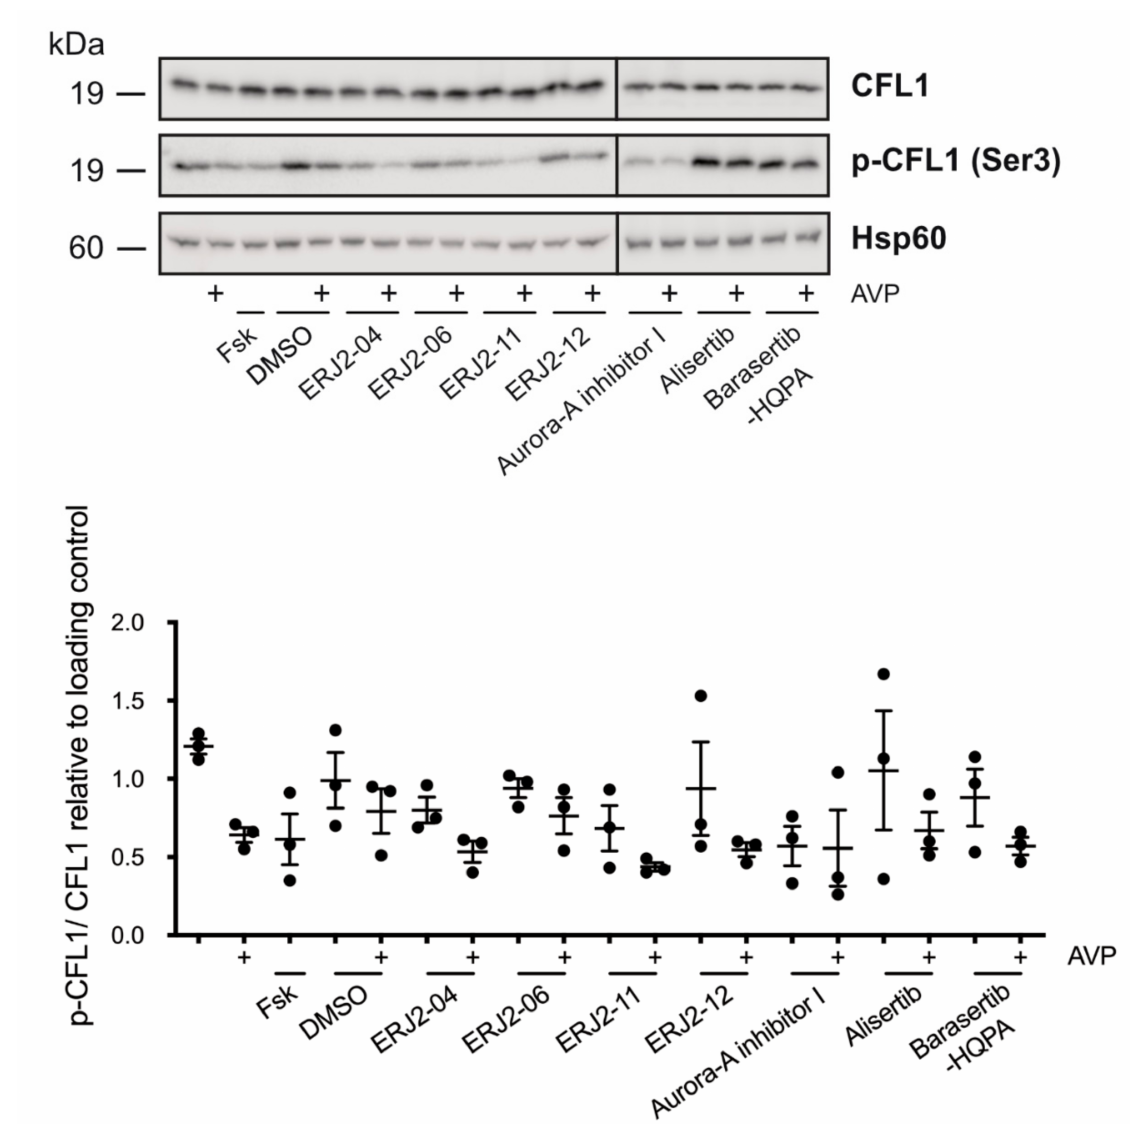
Figure 11. AURKA inhibitors affect the phosphorylation of CFL1 in primary IMCD cells. Cells were left untreated or treated with DMSO (0.2%, 1 h) or compound (20 µ M, 1 h) alone or in combination with forskolin (Fsk; 30 µ M, 30 min) or arginine-vasopressin (AVP; 100 nM, 30 min). Cell lysates were prepared and CFL1, phosphorylated (p-)CFL1 and Hsp60 as loading control were detected by Western blotting using specific antibodies. The signals were semi-quantitatively analyzed by densitometry and normalized to the loading control. Shown are representative blots and means ± SEM of three independent